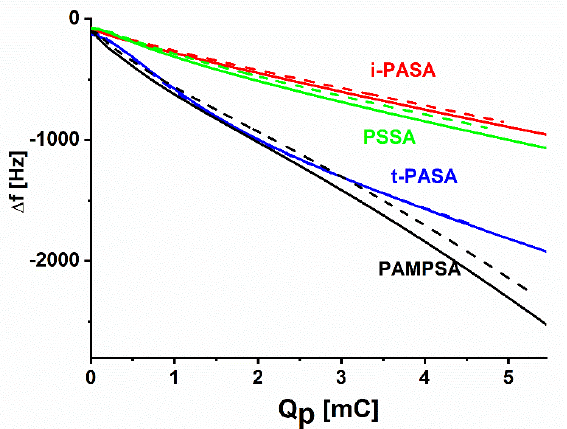
Figure 2. Microgravimetric measurements in the course of polymerization at small polymerization charges in the presence of PAMPSA 9 (black), t-PASA (blue), i-PASA (red) and PSSA (green). Full and dashed lines correspond to thick and thin layers, dashed lines correspond to thick and thin layers, correspondingly.